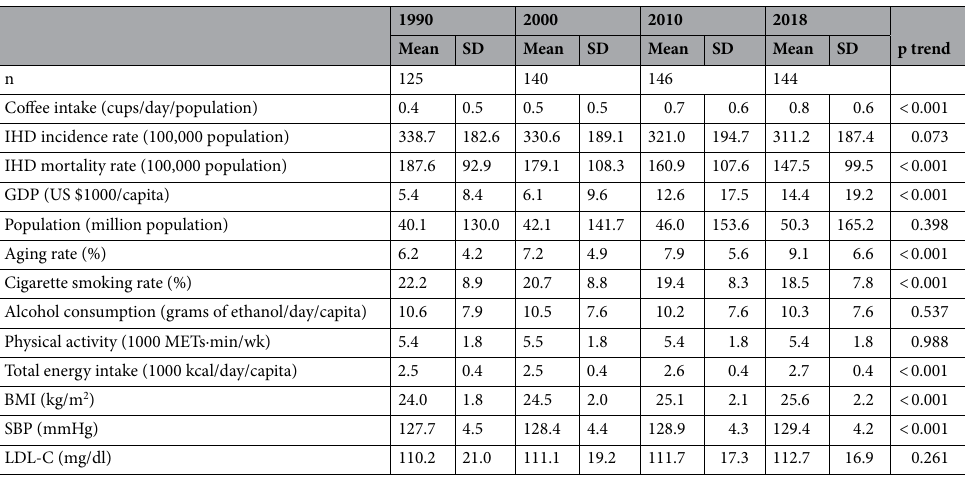
Table 1. Characteristics of the countries by year. BMI body mass index, GDP gross domestic product, IHD ischemic heart disease, LDL-C low-density lipoprotein cholesterol, MET metabolic equivalent, SBP systolic blood pressure, SD standard